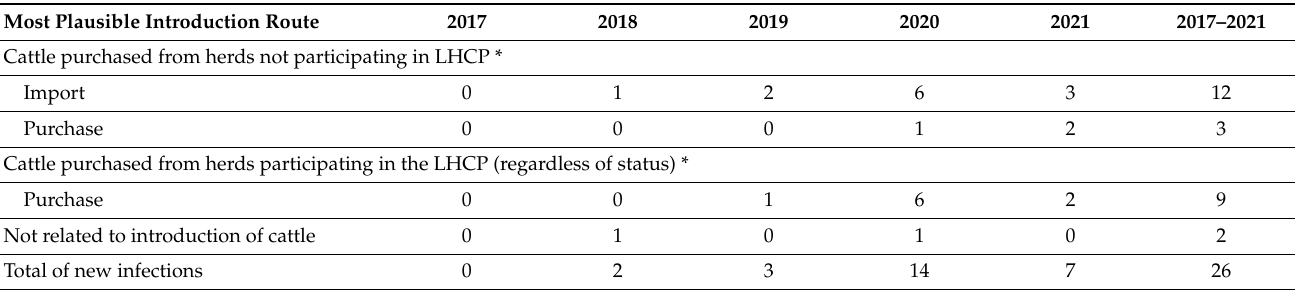
Table 2. Number of new infections of L. Hardjo from 2017 to 2021 in the Netherlands classified by most plausible introduction